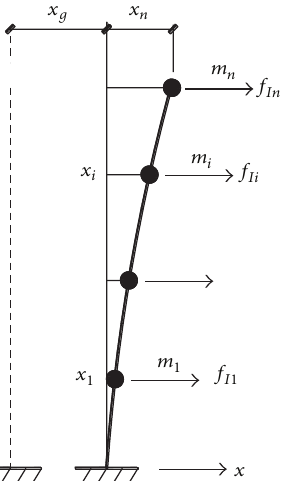
Figure 2: Deformation and force of multiple-degree-of-freedom forced vibration system.